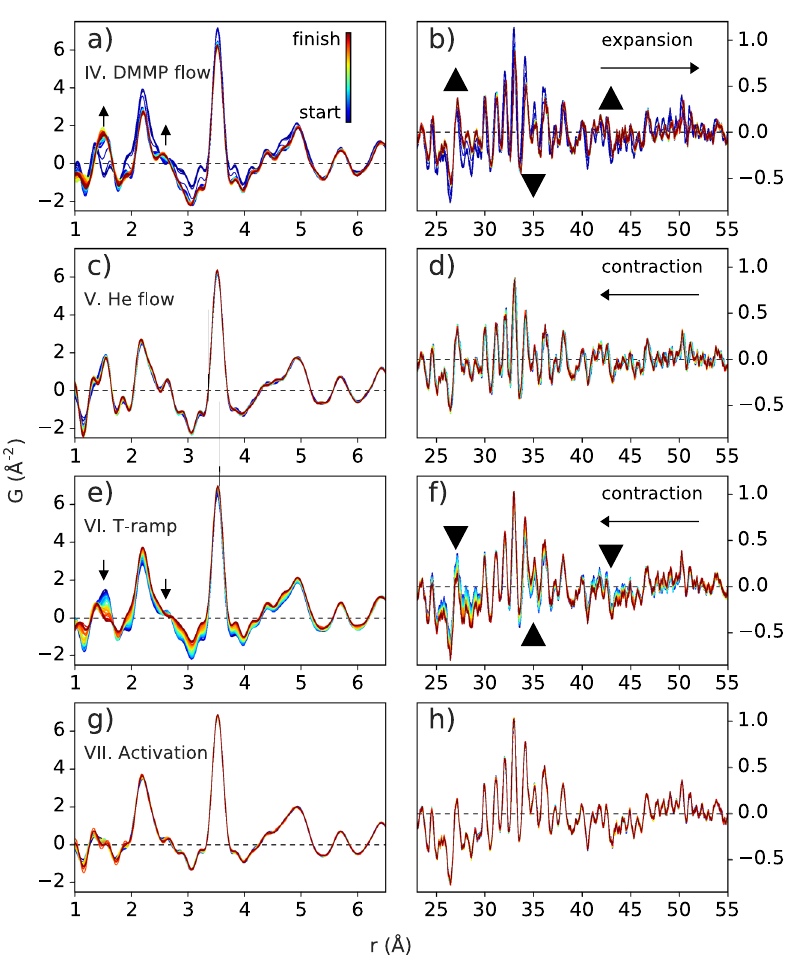
Fig. 4 Changes in the local structure. PDFs are shown over short and long distances during steps IV: DMMP fl ow a , b , V: He fl ow c , d , VI: temperature ramp e , f , and VII: re-activation g , h . The order is start of step (blue) to end (red). Arrows mark the direction of signi fi cant changes in pair correlations or correlated density, and lattice